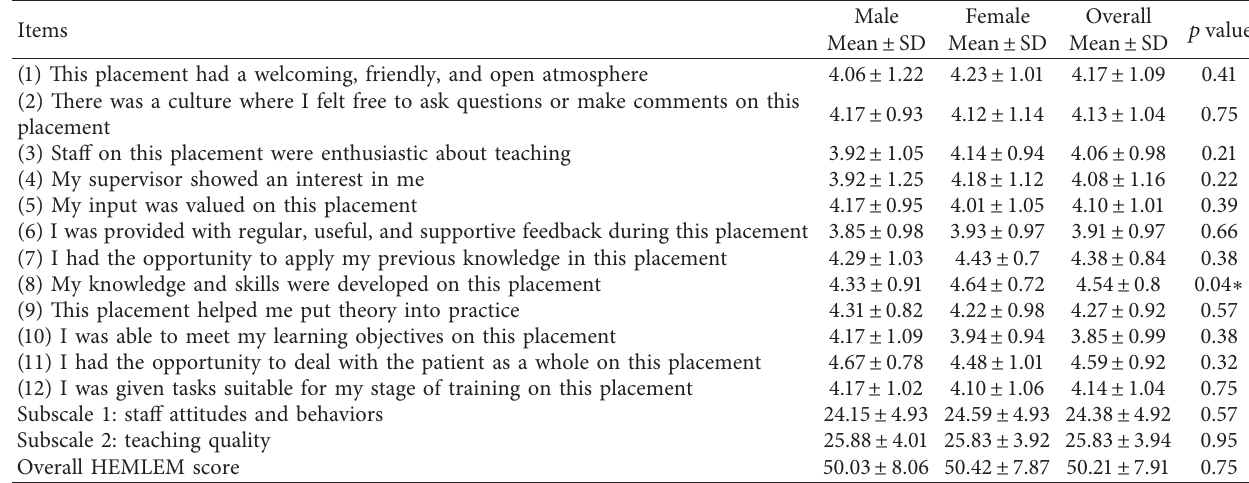
Table 2: Genderwise and overall scores on the HEMLEM